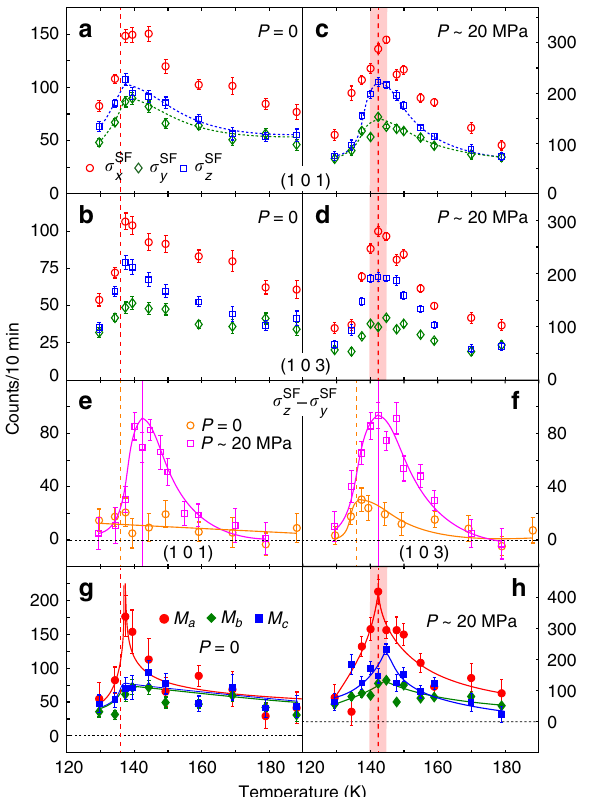
Fig. 3 Temperature dependence of the magnetic scattering across T N at E = 2 meV without and with uniaxial pressure. Temperature dependence of σ SF x , σ SF y , and σ SF z at E = 2 meV of a , b uniaxial pressure-free 34 and c , d pressured ( P ≈ 20 MPa) BaFe 2 As 2 at a , c (1, 0, 1) and b , d (1, 0, 3). e , f Comparison of P = 0 and P ≈ 20 MPa ð σ SF z (cid:2) σ SF y Þ at Q 1 = (1, 0, 1) and Q 2 = (1, 0, 3). Temperature dependence of M a , M b , and M c at E = 2 meV for g uniaxial pressure-free and h pressured sample estimated from the data in ( a – d ). The dotted and solid lines are guides to the eye and the error bars represent 1 standard deviation. The vertical dashed and solid lines mark T N / T s at P = 0 and P ≈ 20 MPa,